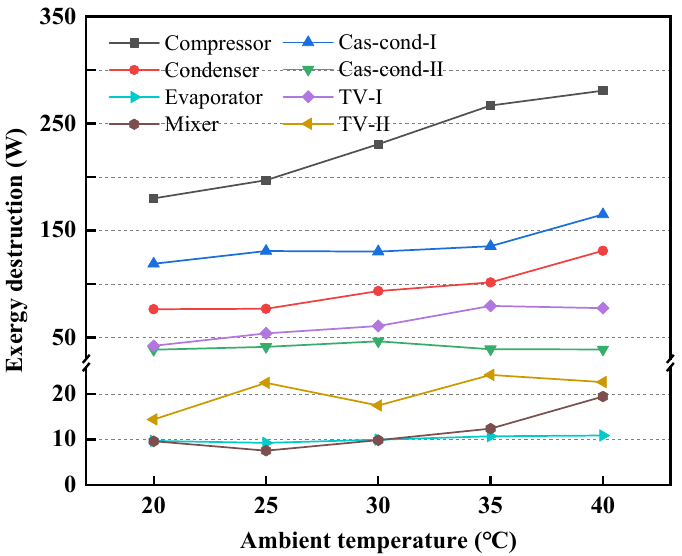
Figure 8. The exergy destruction changes of each component at different ambient temperatures.